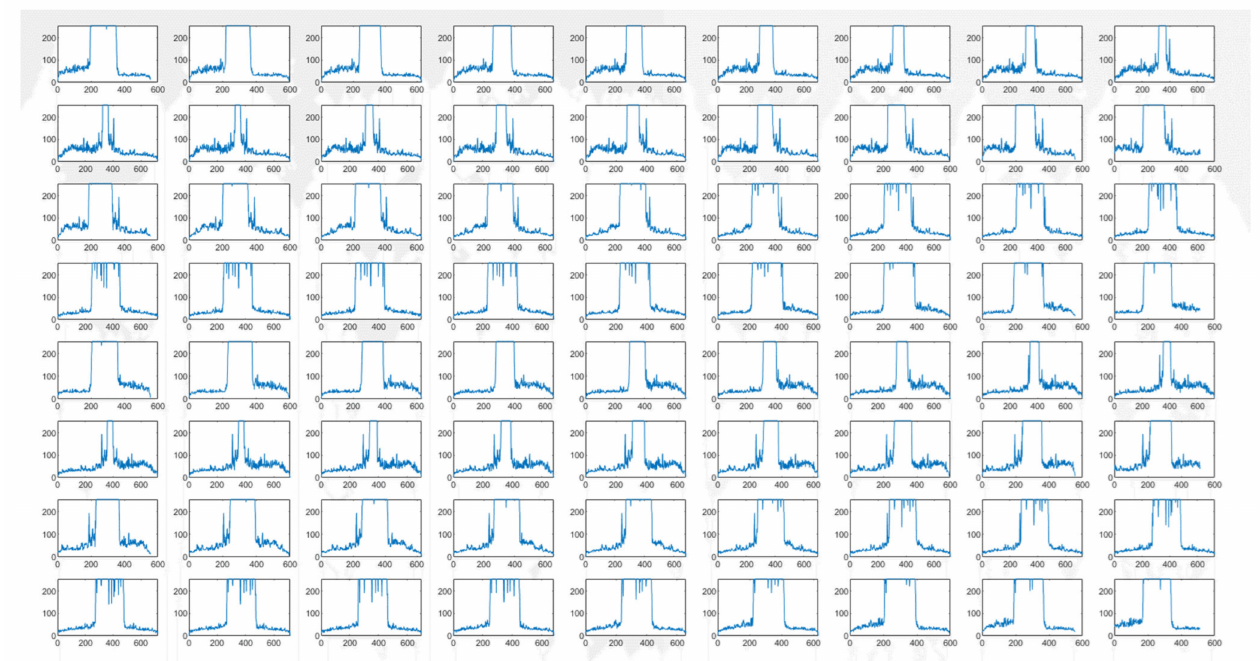
Figure 5. Projection in the x -direction per rotation. There are 72 sub-figures in total where 72 is from 360 ◦ /5 ◦